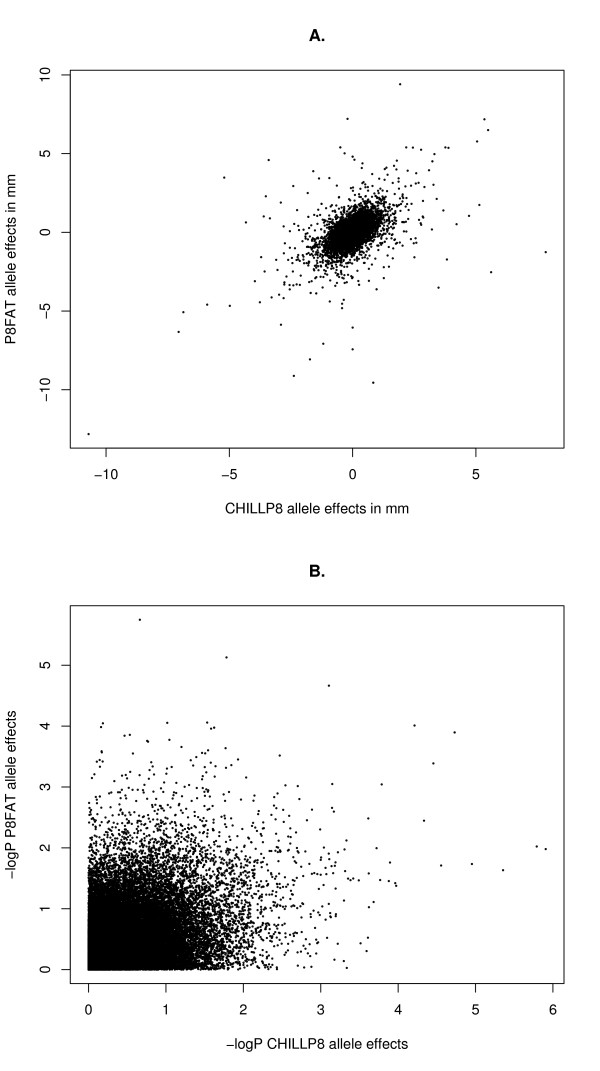
The divergence between allele effects and their significance in the GWAS of the two trait measurements. A. Bivariate plot of allele effects of CHILLP8 (x-axis) and P8FAT (y-axis), the relationship has a correlation of r = 0.53, B. Bivariate plot of -logP values of CHILLP8 (x-axis) and P8FAT (y-axis), the relationship has a correlation of r = 0.36.